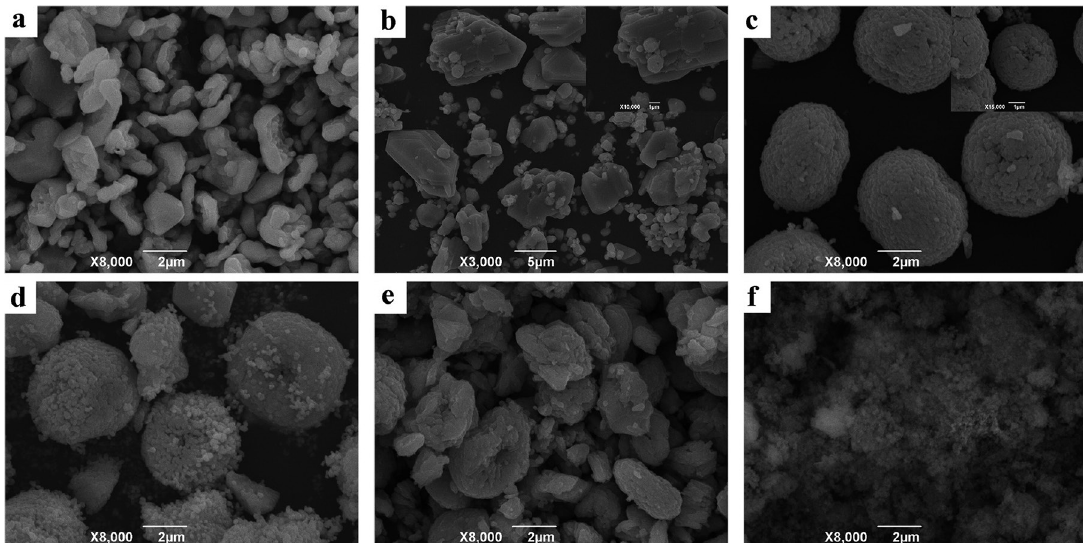
products obtained for different pH for 24 h at 180 o C. (a) pH=1.73, (b) pH=3.00, (c) pH=5.00, (d) Figure 4: SEM images of CdMoO 4 pH=7.00, (e) pH=9.00, and (f) pH=11.00.